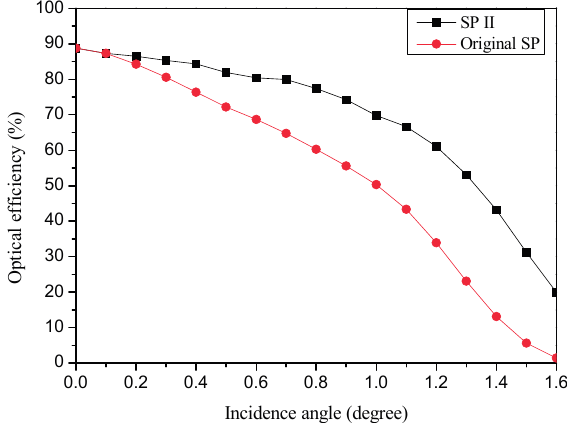
Figure 19. Optical efficiency of the Fresnel lens with SP SOE and SP II